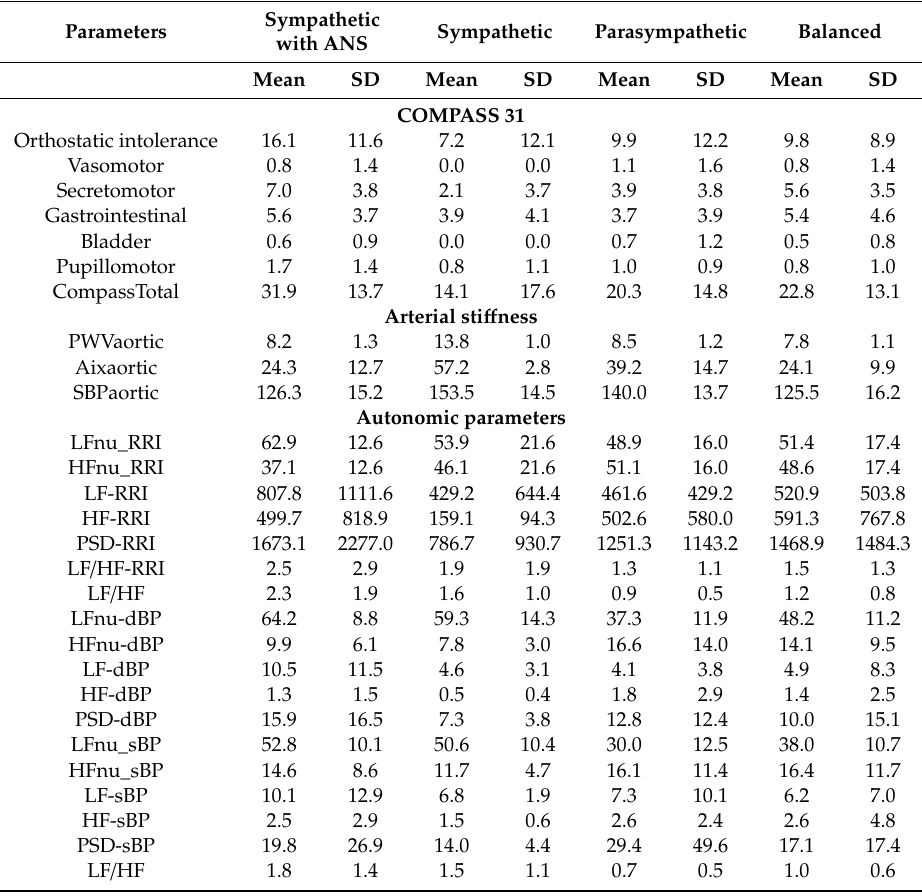
Table A1. Detailed clinical characteristics of each